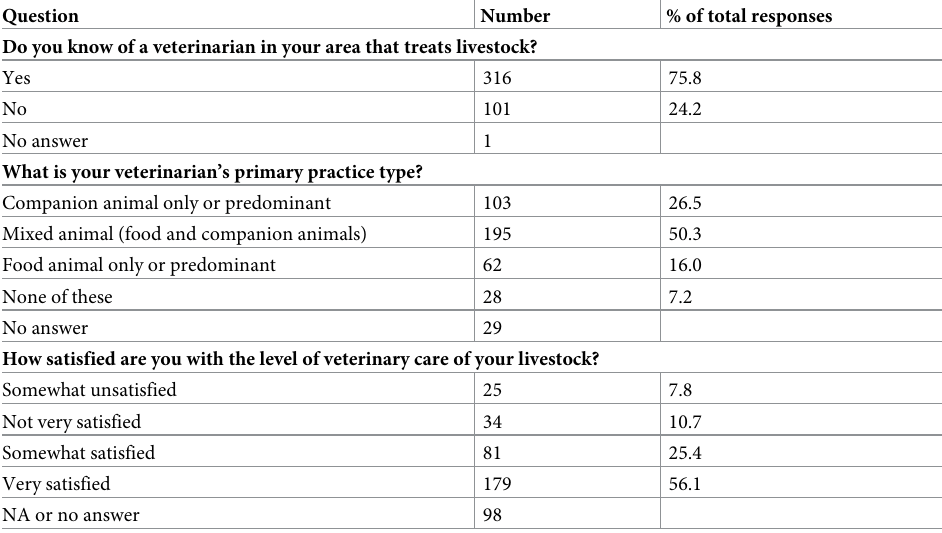
Table 3. Access to veterinary care of small-scale livestock and poultry owners in 4 western states (Washington, California, Colorado and Oregon). Question Number % of total responses Do you know of a veterinarian in your area that treats